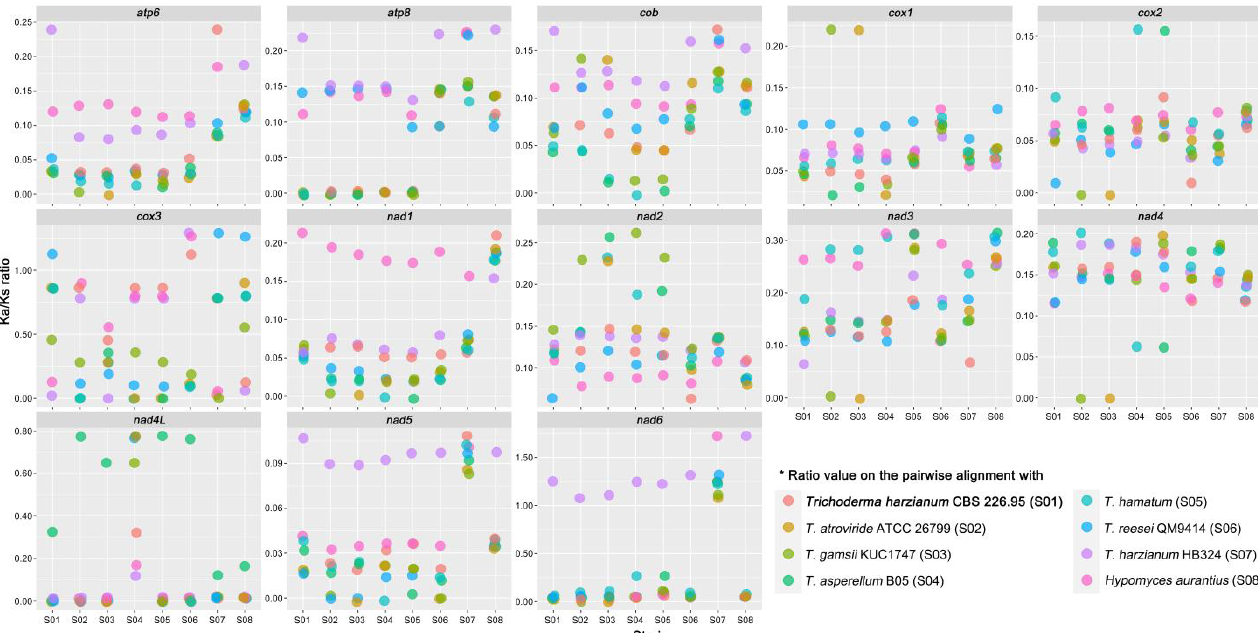
Figure 5. Analysis of Ka/Ks ratios of the core PCGs. Obtained values are described in Table S11. Ka, nonsynonymous substitution rate; Ks, synonymous substitution rate.